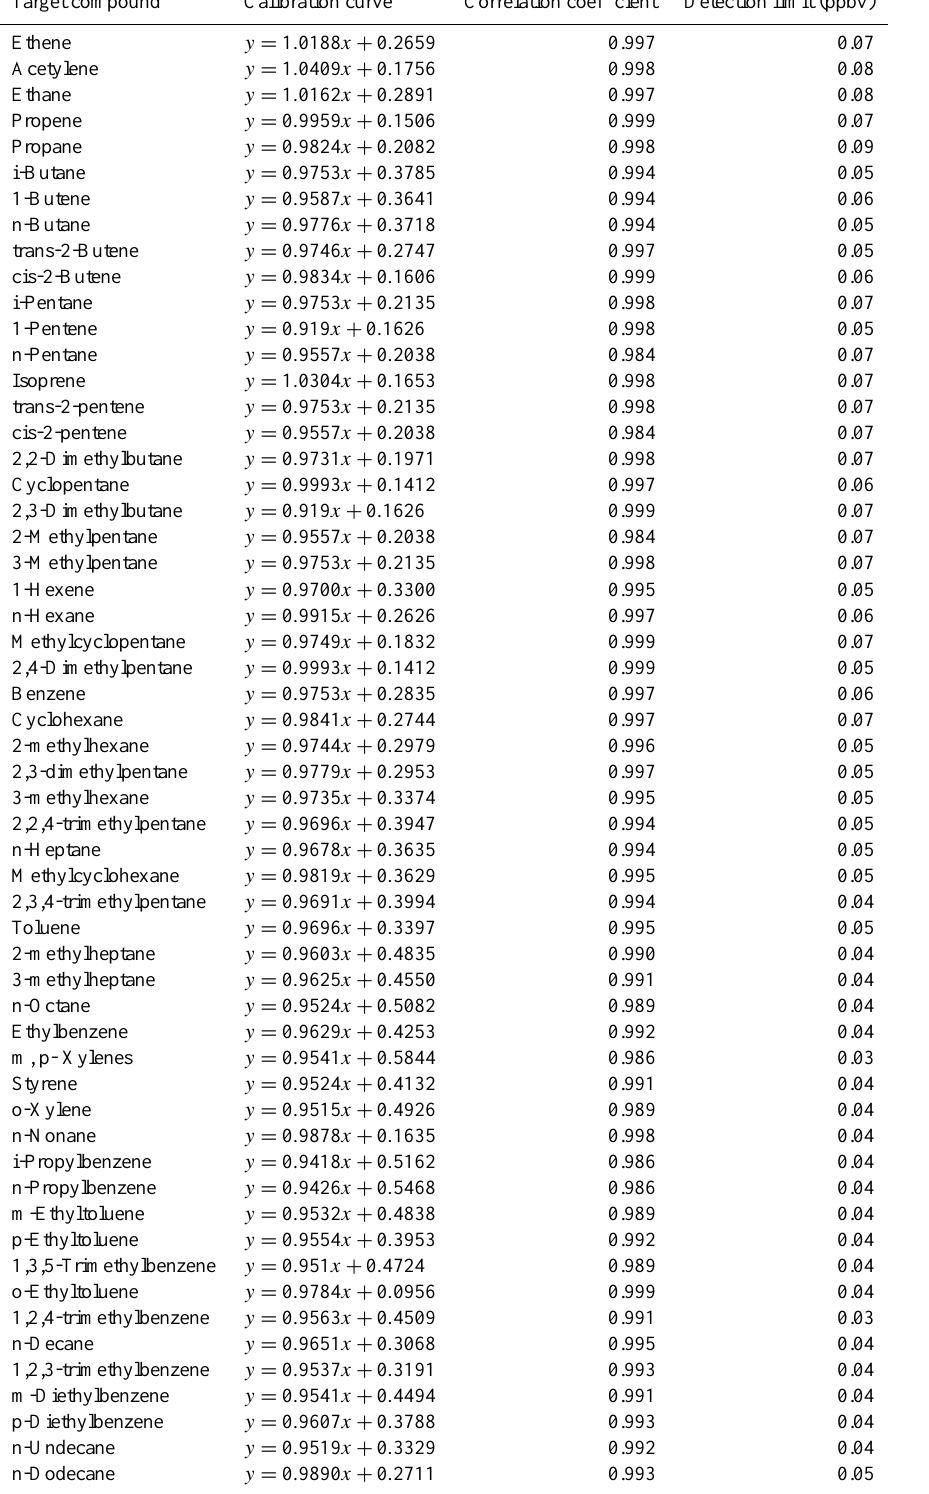
Table 2. The calibration curves and detection limits of VOC species. Target